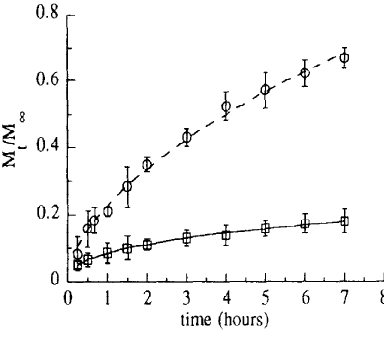
Figure 5. Tetracycline release profiles from poloxamer (- - -) and monoglyceride ( ― ) based gels. Kinetics were determined by equilibrium dialysis. The reported values represent the average of five independent experiments, bars = S.D. (Reprinted with permission from reference [34]. Copyright 1996 Elsevier).